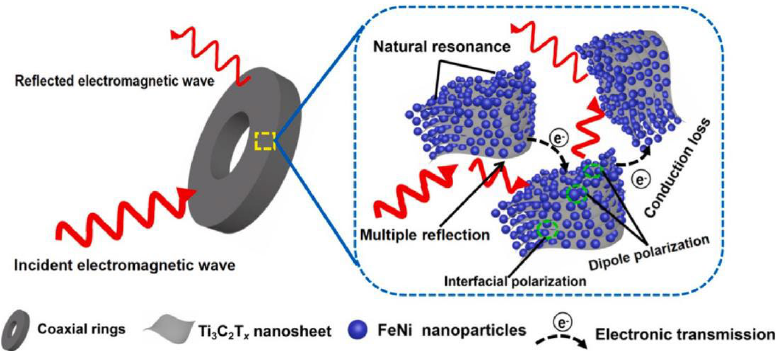
Figure 37. Schematic illustration of MA mechanisms for the FeNi/Ti 3 C 2 T x MXene-filled MAMs